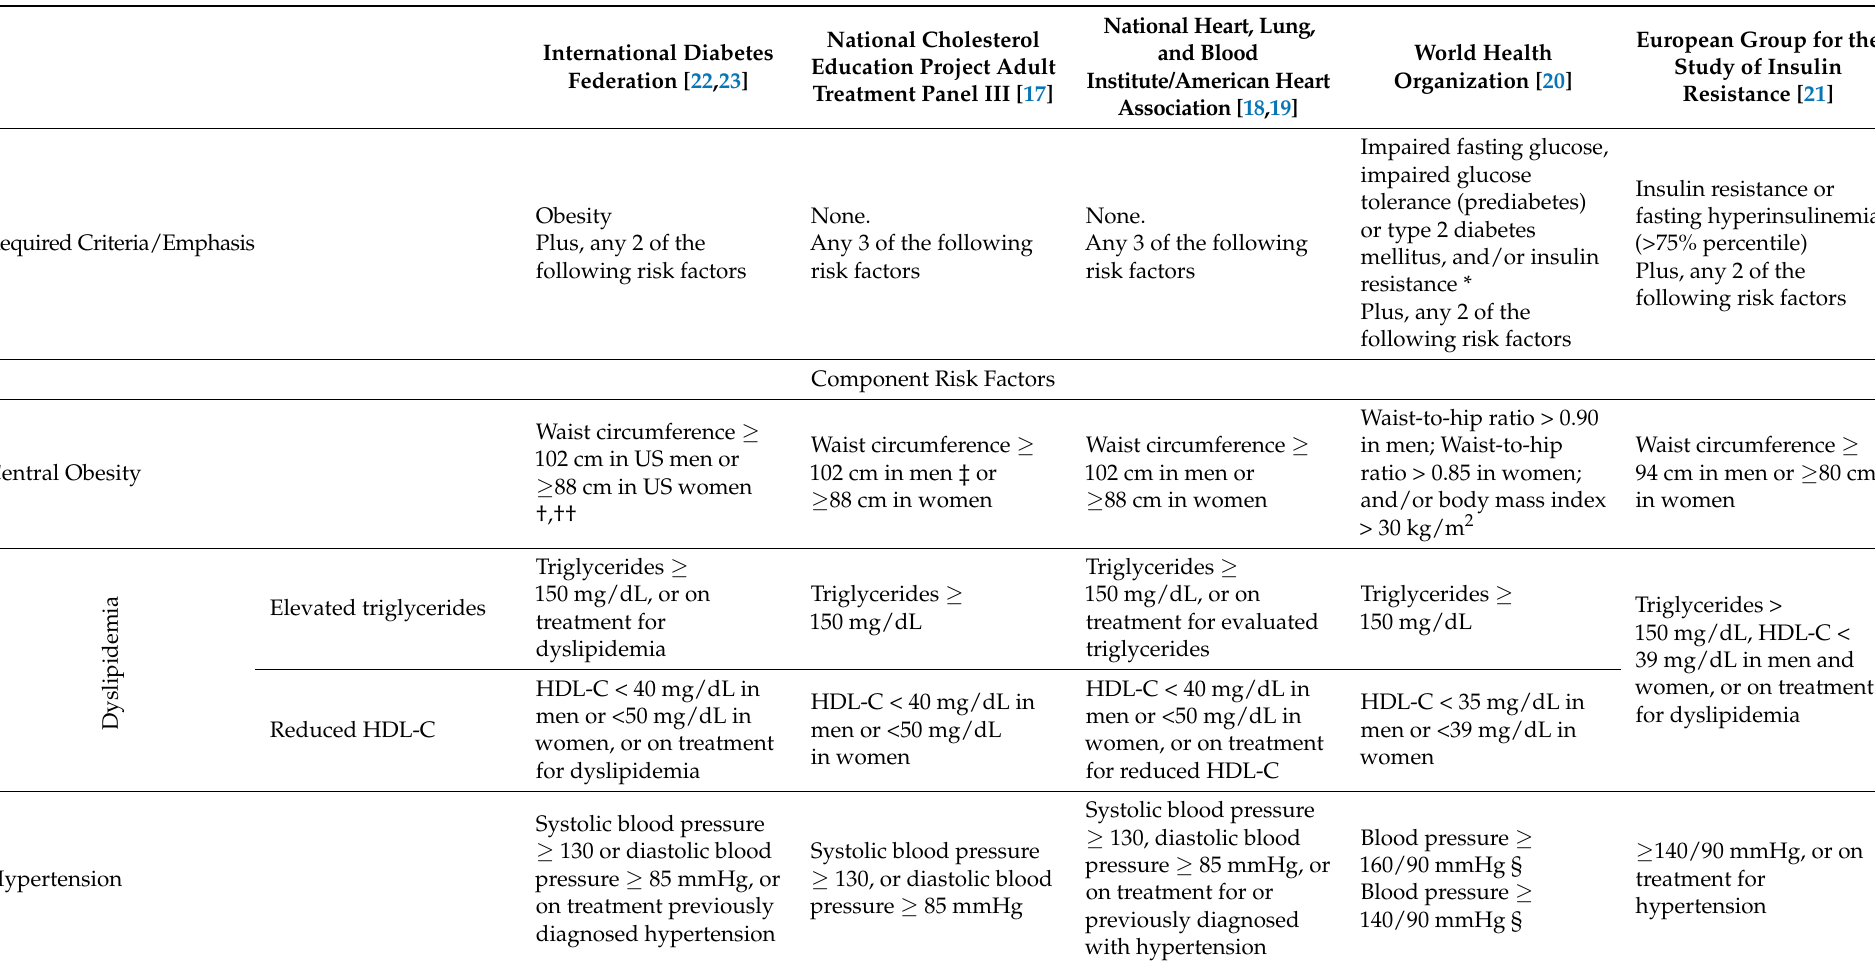
Table 1. The most recognized definitions for identifying and diagnosing cardiometabolic syndrome and its component risk